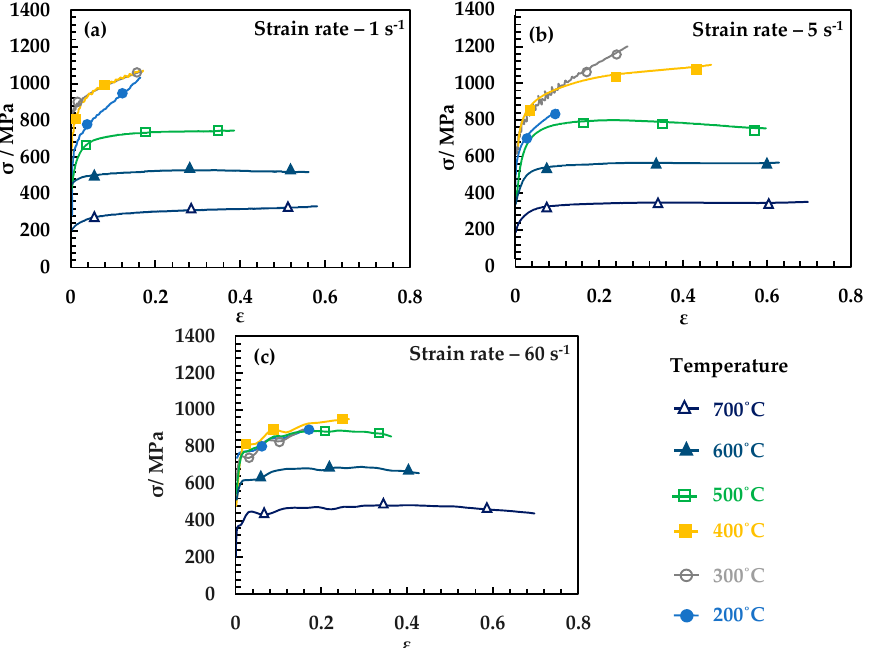
Figure 3. Flow stress at strain rate 1 s − 1 ( a ), 5 s − 1 ( b ), and 60 s − 1 ( c ) with the temperature between 200 °C and 700 °C.